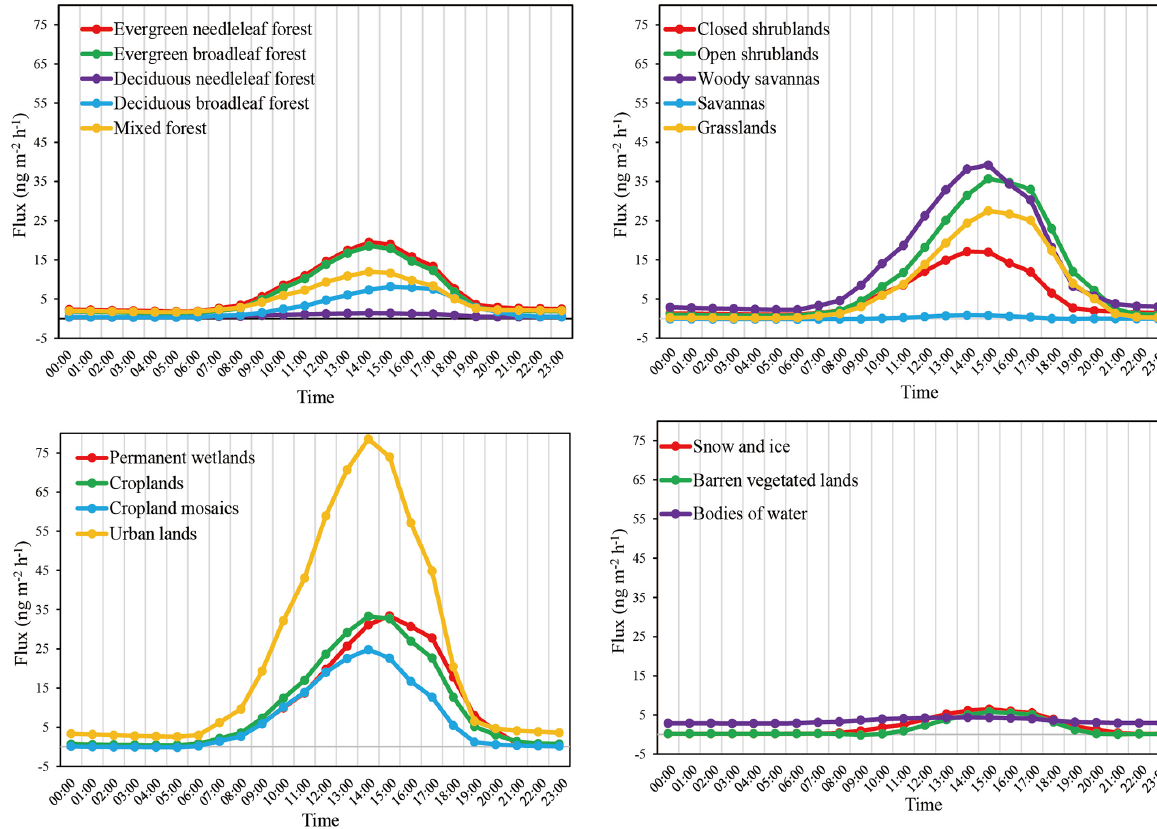
Figure 5. Diurnal variation of mean simulated exchange fluxes of Hg 0 over soil and water surfaces in the model domain (UTC +